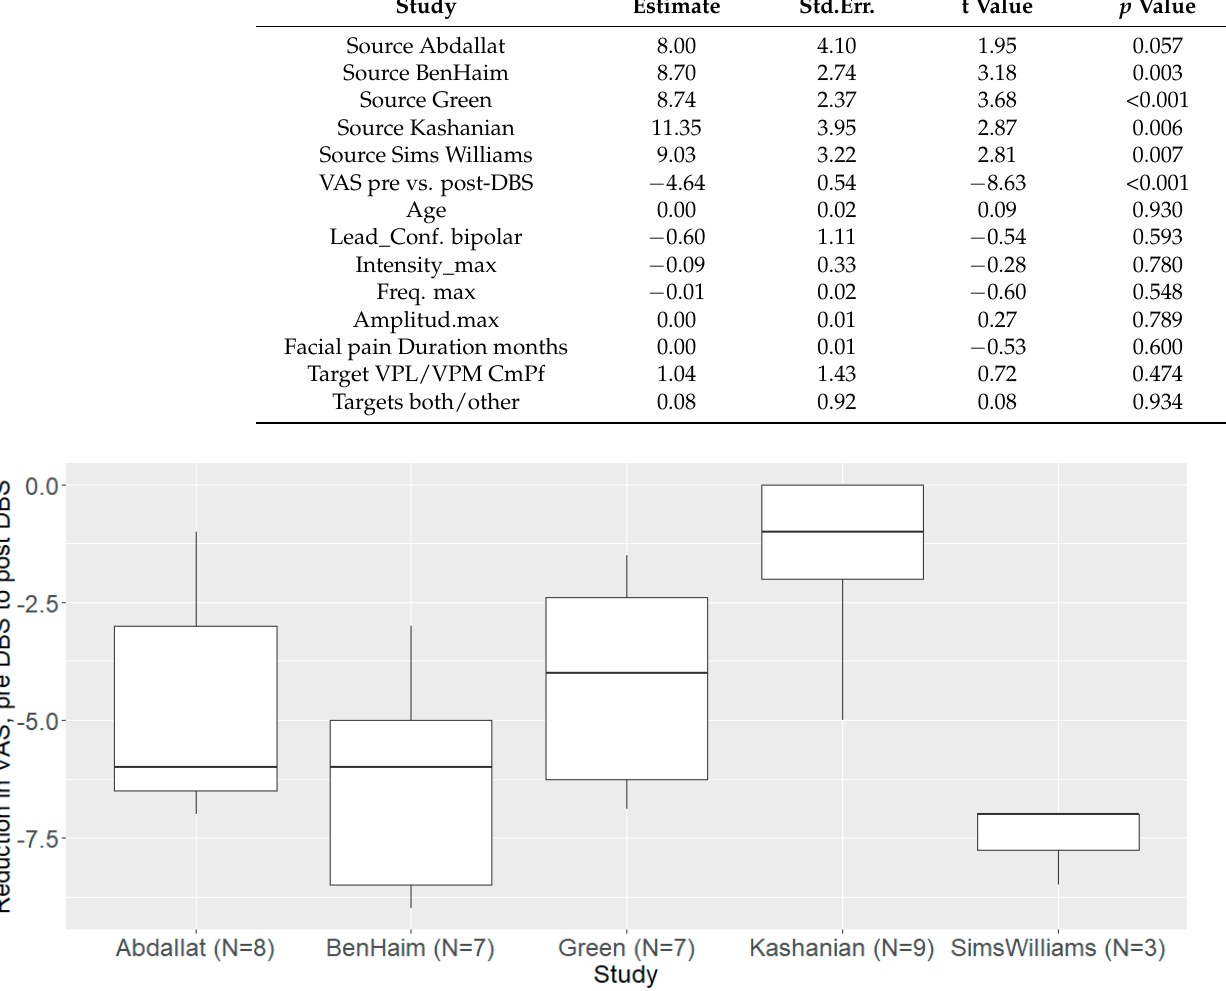
Figure 3. The VAS level changes pre- and post-DBS and numbers of patients when longer follow- up periods were considered: T0 (baseline), T1 (3 months), T2 (12–24 months), T3 (24–47 months), and T4 ( ≥ 48 months). The boxplot shows the median, the upper and lower quartiles, and the two whiskers. The upper whisker extends from the upper quartile to the largest value no further than 1.5 × IQR from the upper quartile, where IQR is the inter-quartile range, or distance between the upper and lower quartiles. The lower whisker has an analogous definition.